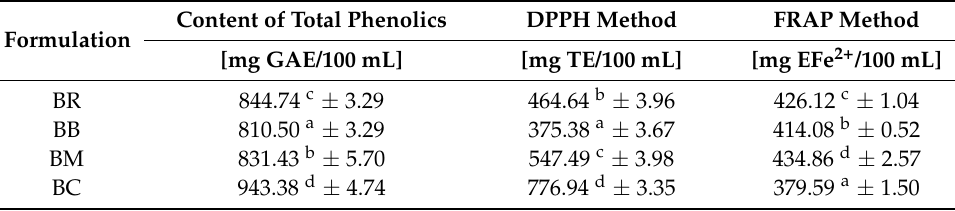
Table 3. Total phenolics and antioxidant capacity of the developed beverages.